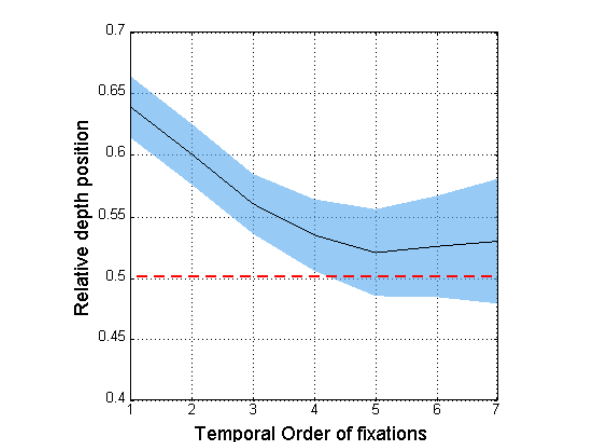
Figure 6 . Relative depth position of fixations as a function of temporal order. The red dash line indicates the average value of relative depth of all objects displayed in the experiment. The light blue region represents the 95% confident